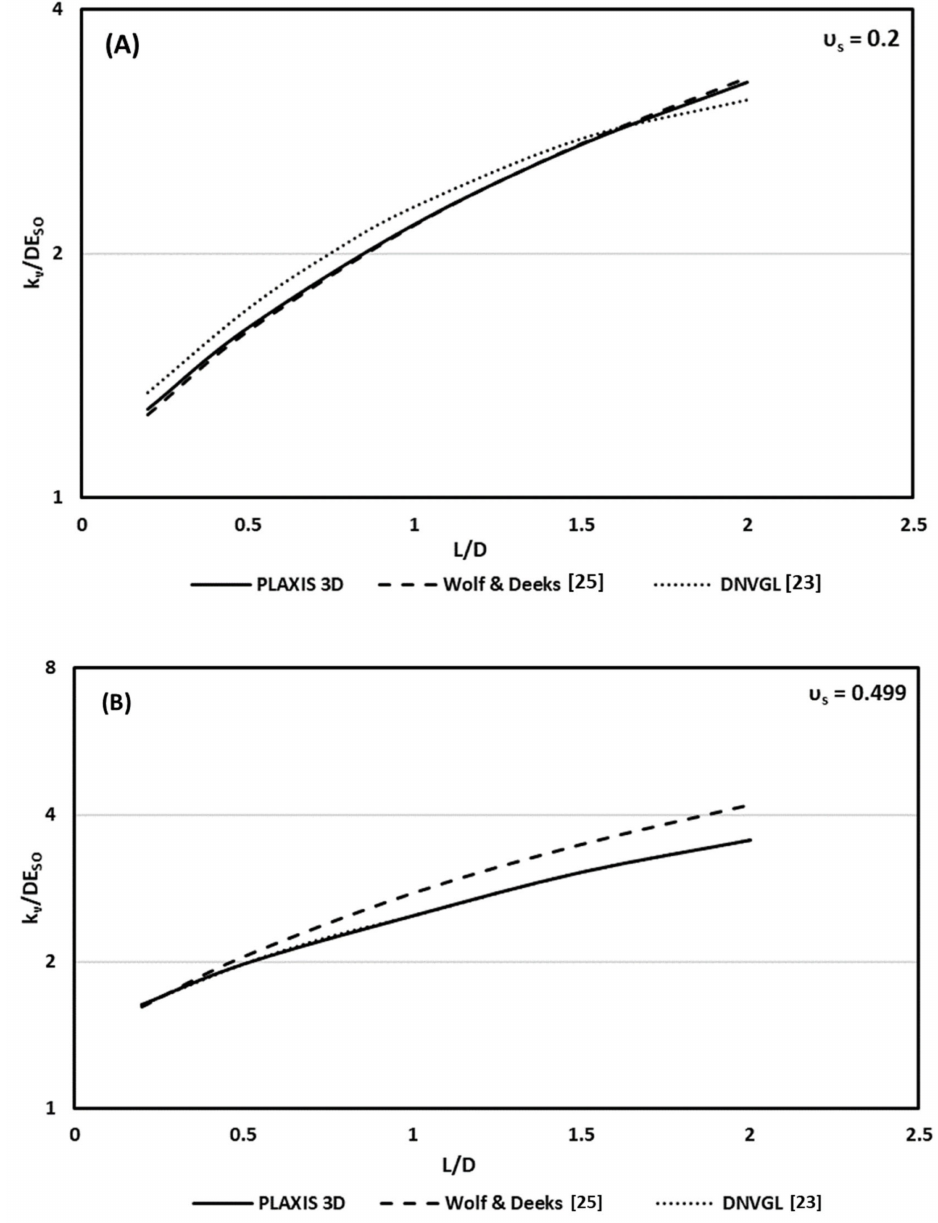
Figure 7. Vertical static stiffness functions for rigid caissons in homogeneous ground profiles at two Poisson’s ratios ( A ) υ s = 0.2, and ( B ) υ s =